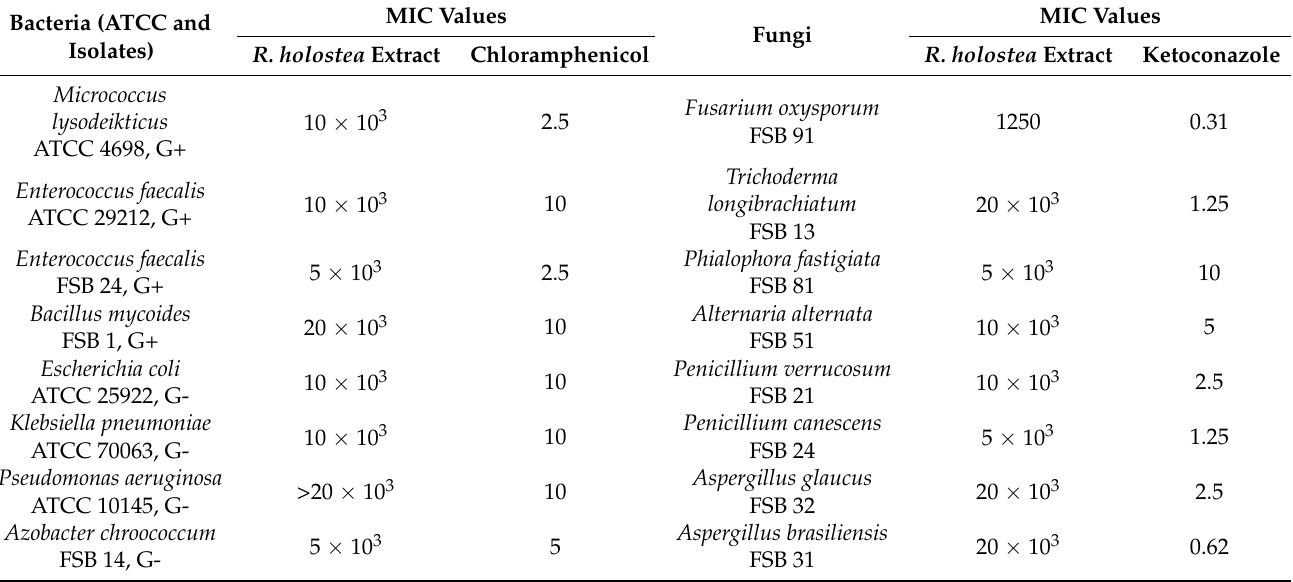
Table 4. Antimicrobial properties of R. holostea aerial part methanol